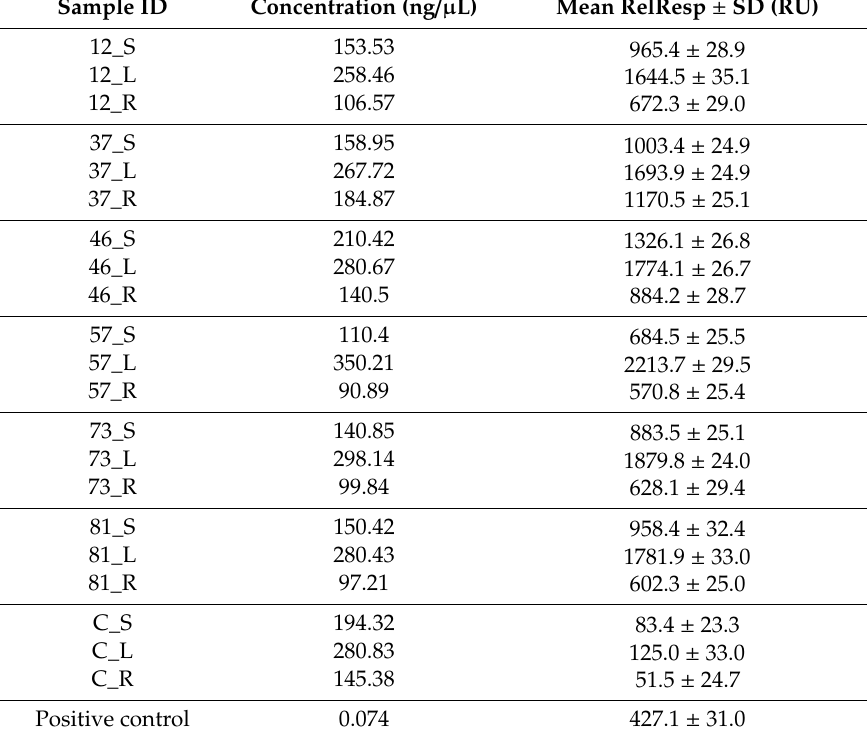
Table 4. Results of the SPR measurements for the DNA sample isolated from the stems, leaves, and roots of non-transgenic (C) and transgenic tobacco on the SA sensor, with an immobilization level of 615.1